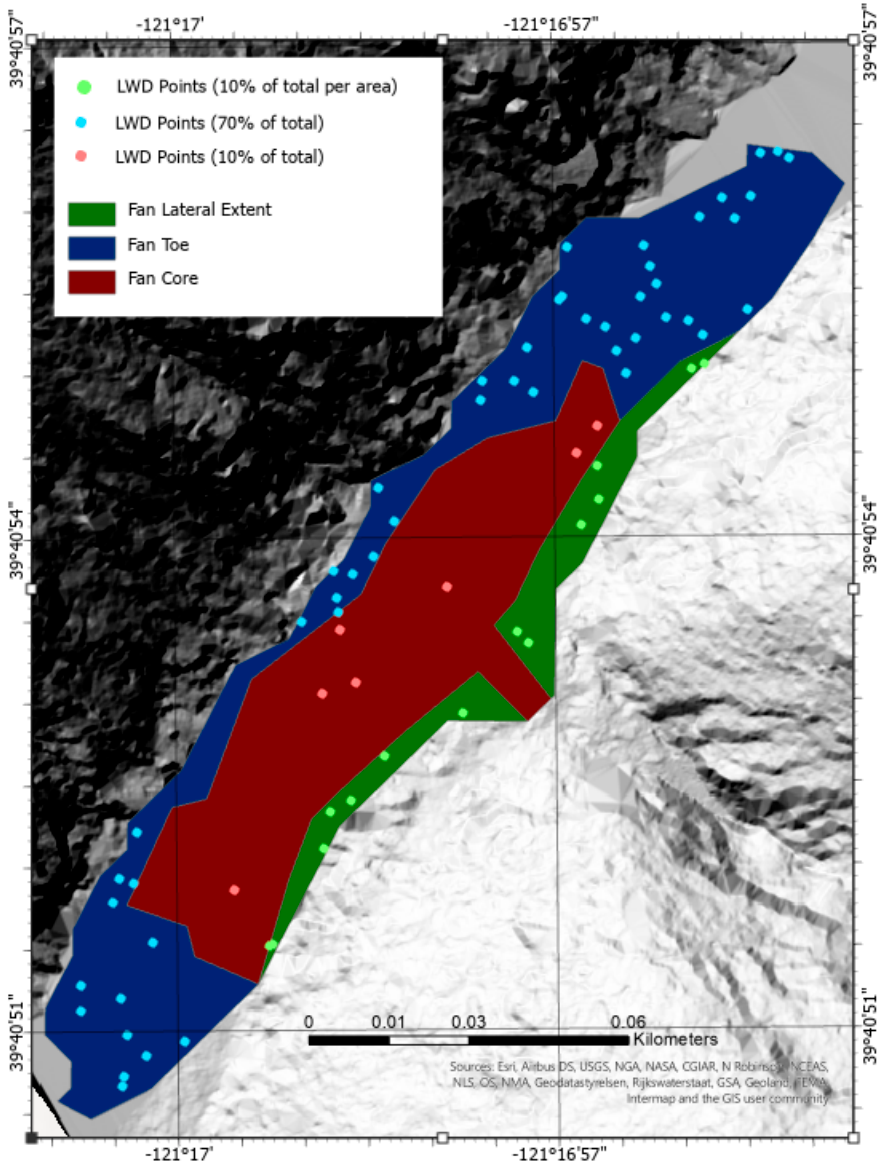
Figure 5. Bins for randomly placing LWD on the debris flow fan. Seventy percent of the points are in the blue area and each remaining area has 10% of the total amount of LWD counted in the water- shed.